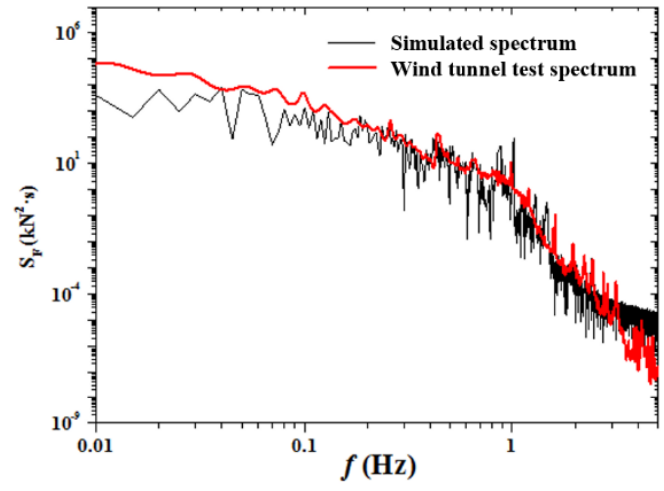
Figure 12. Validation of the simulated base shear force.